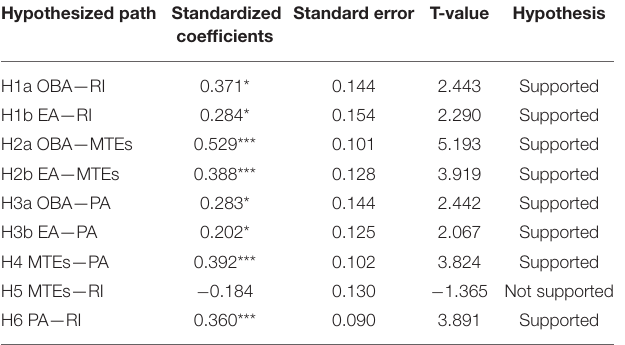
TABLE 3 | Structural equation modeling results.